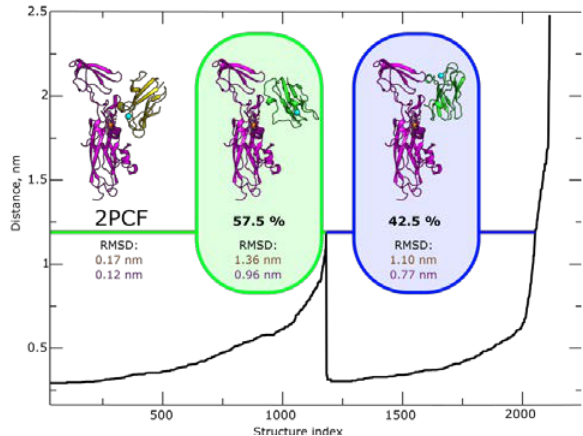
Fig. 4. Structures of encounter protein complexes of plastocyanin and cytochrome f with electrostatic attraction energy more than 8 kT. Left – experimentally determined structure from PDB. Centre – ‘productive’ simulated configuration. Right – ‘unproductive’ simulated configuration. The plot of the reachability distance represents the hierarchical tree with two well separated branches obtained by the density- based clustering [24].